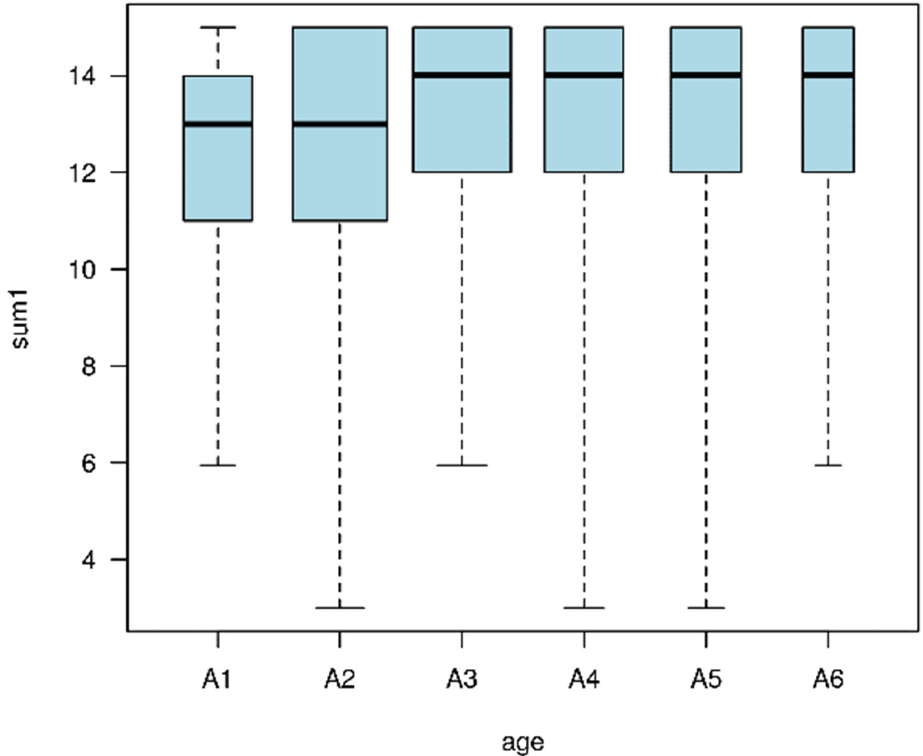
Figure 6. Distribution of sum1 among age groups.